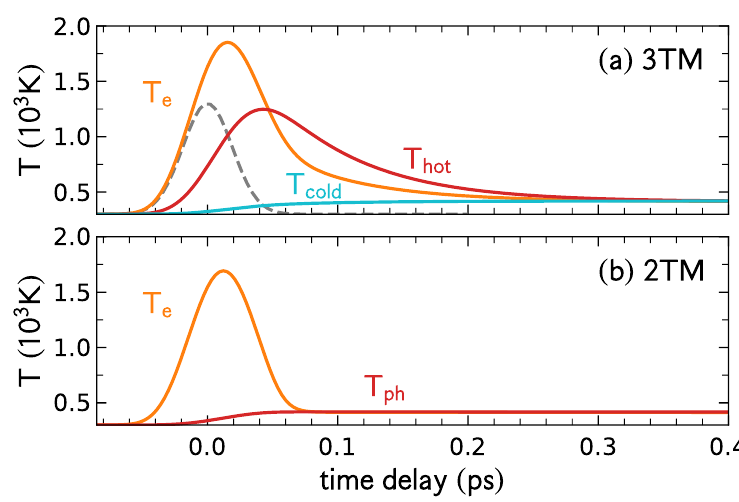
Figure 2: (a) Time evolution of the characteristic effective temperatures T T for the three-temperature model suitable for hot phonons. The grey dashed line cold shows the pulse profile, with the pulse duration of 45 fs and an absorbed fluence of 12 J / m 2 . (b) Similar as in panel (a) within the assumption of thermal distribution (two-temperature model) of the lattice modes as described with Eqs. (10) and (11). Partial readaptation from Ref. [ 37 ]